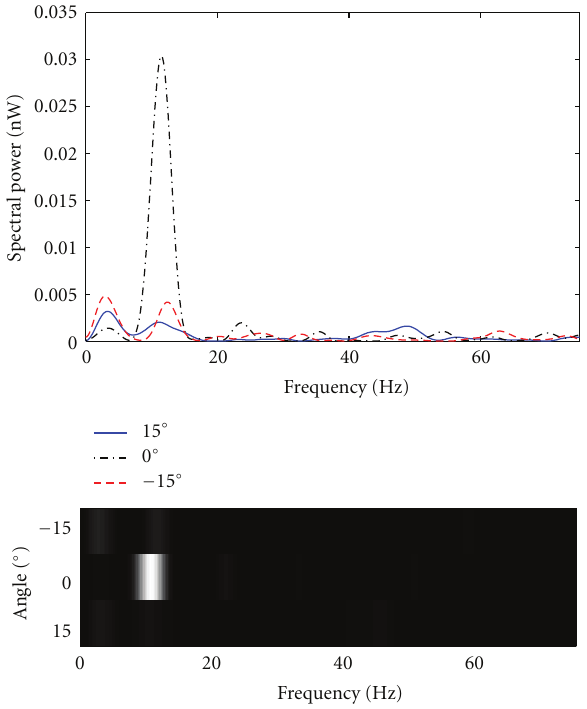
Figure 9: Spectrogram of the received signal when a speaker, producing a 10Hz tone, is placed at 0 ◦ .